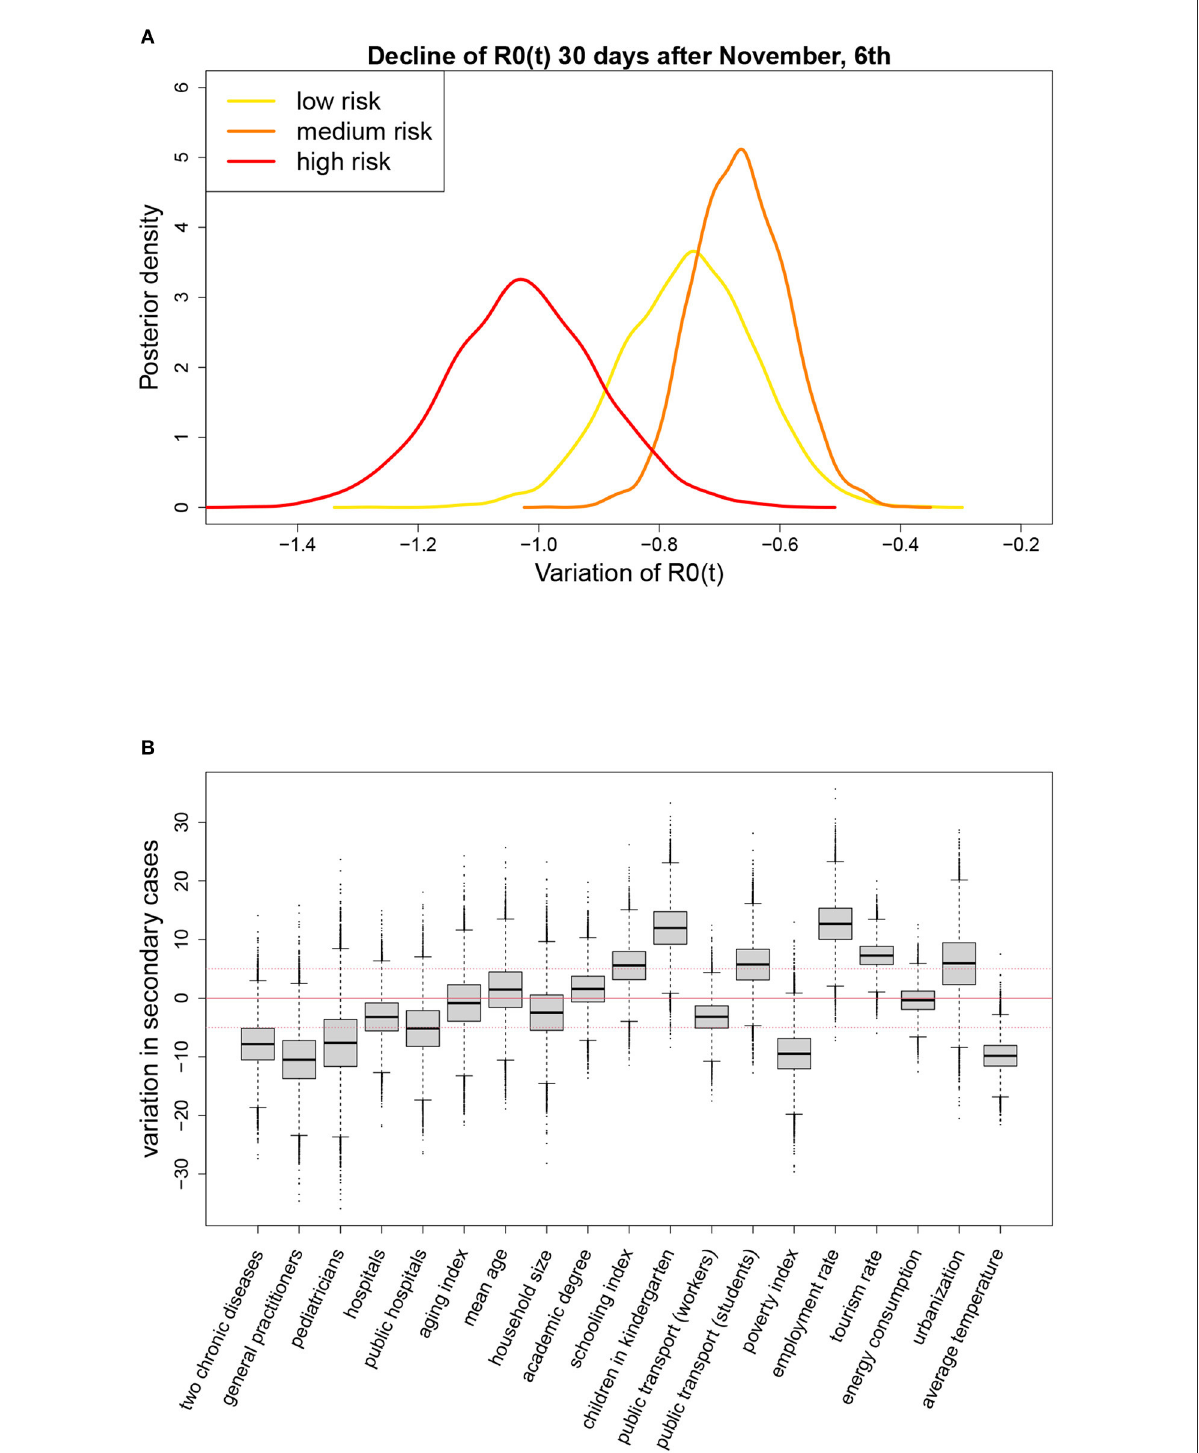
FIGURE4 (A) Posterior distributions of the change in R 0 ( t ) during the first 4 weeks following the introduction of the restriction measures on November 6th, by level of alarm assigned to the region, and (B) results of the meta-regressions on the average value of R 0 ( t ) from October to December (posterior distribution of the variation in the average value of R 0 ( t ) × 100, associated to a change in the meta-regressor equal to its observed interquartile range); p = 1.15 % , T = 14